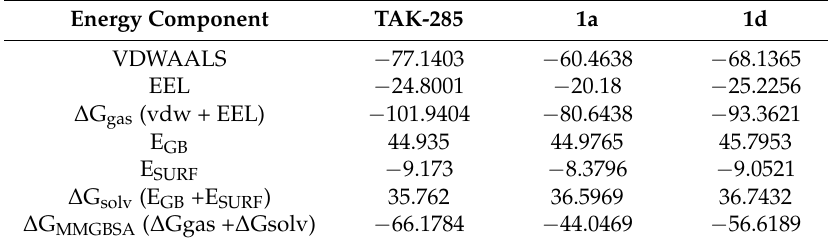
Table 3. Total binding energy and its components of TAK-285, 1a and 1d complexes obtained from